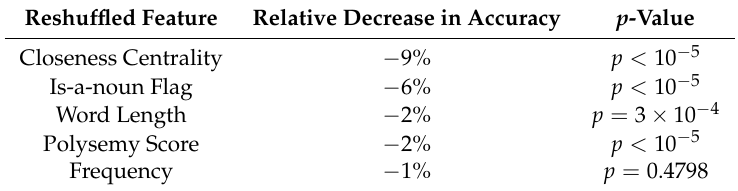
Table 1. Feature importance analysis for the logistic regression classifier and the model with frequency, length, polysemy, is-a-noun flag and multiplex closeness centrality trained for the developmental stage n = 264. Only one feature at a time is randomly reshuffled while the others are kept fixed. The average relative decrease in accuracy from the original model performance (accuracy 67.7 ± 0.2%) is computed. A location equivalence test(Kruskal-Wallis) between the accuracy of 50 reshuffles and original accuracy provides the reported p-values. Features are ranked in decreasing order of relative accuracy